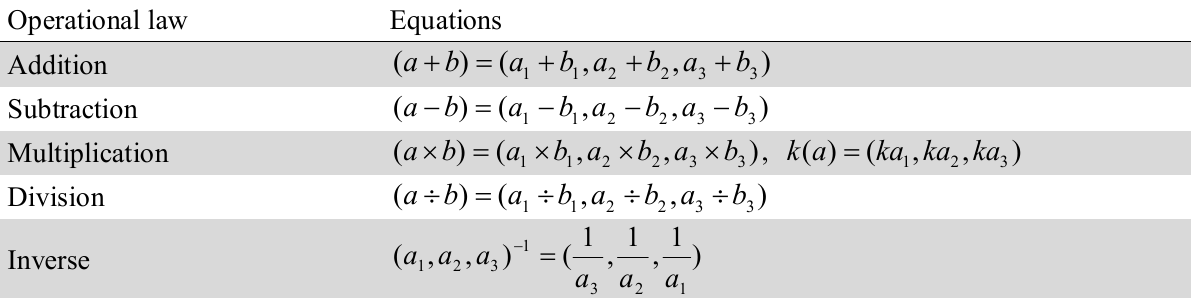
Basic equations of the two triangular fuzzy